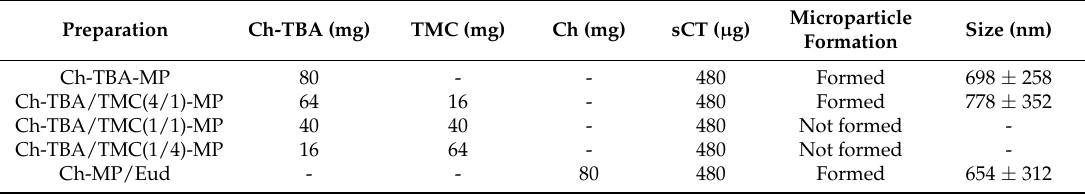
Table 1. Formulations and particle formation and characteristics of Ch-TBA-MP, Ch-TBA/TMC-MP, and